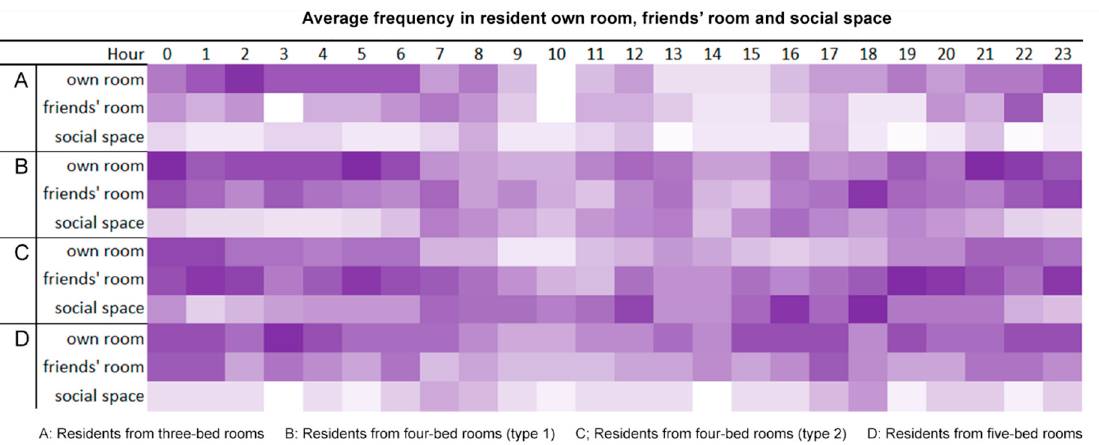
Figure 11. Colour-coded sequential patterns. This chart illustrates the number of visited locations per resident. Table 3. Number of residents involved in more than 48 locations in a day. Room Type